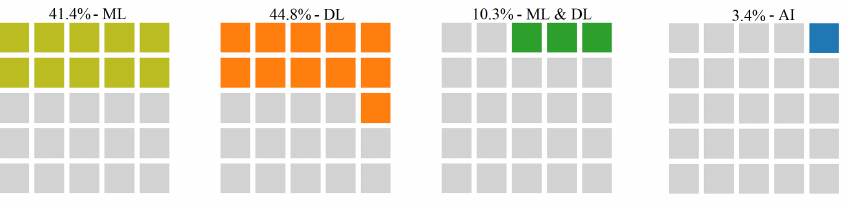
Figure 16. The relationship between HAR challenge and AI techniques categories used to address it.